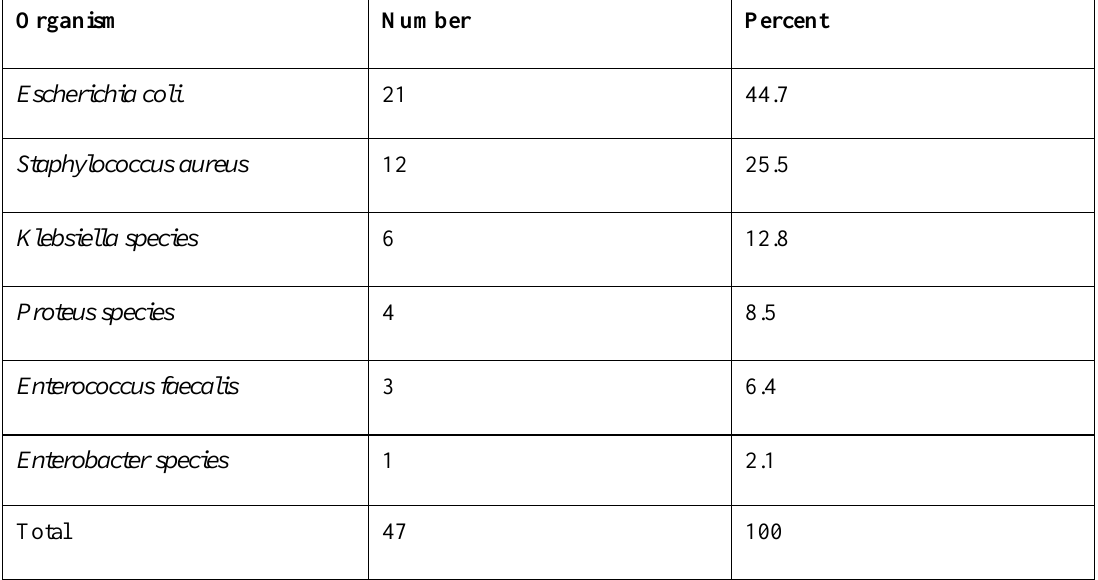
Table 3. The profile of bacteria in cases of asymptomatic bacteriuria in students. Organism Number